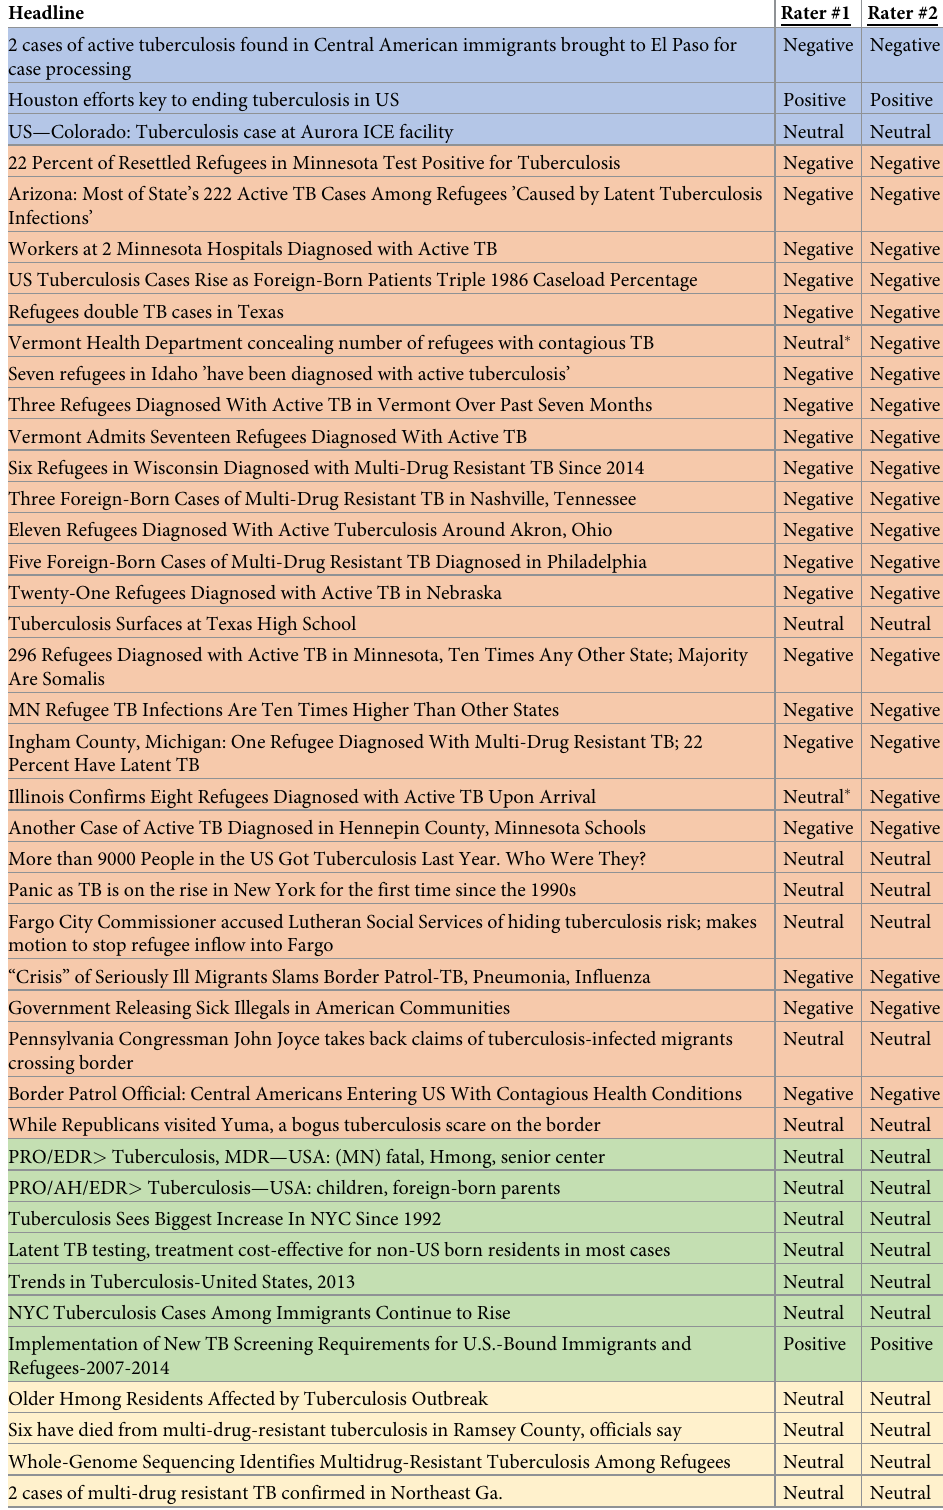
Table 3. Sentiment categorization by article and